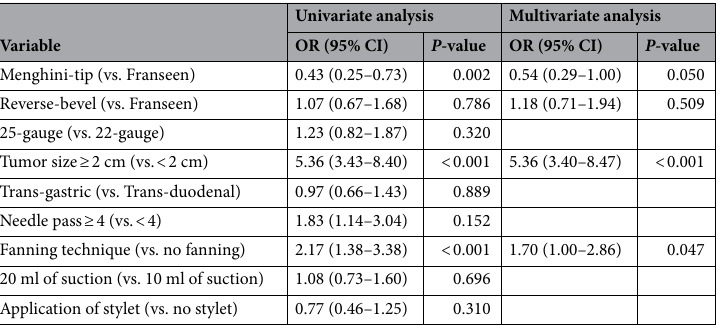
Table 4. Variables for accurate diagnosis according to logistic regression models. OR, odds ratio; CI, confidence interval.